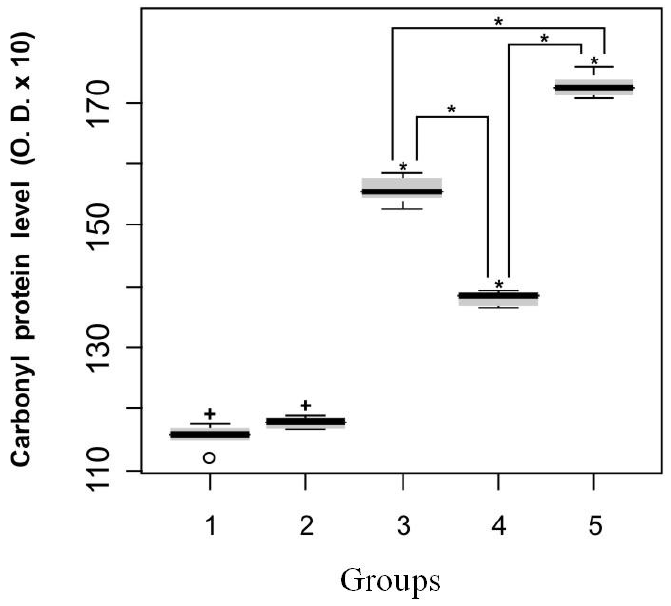
FIGURE 2 - Box plots of the protein carbonyl level (optical density (O.D.) x 10) determined in plasma samples from rats which underwent intestinal ischemia/reperfusion (I/R). Group 1- Control; Group 2 - Sham laparotomy with Propofol; Group 3 – I/R with Propofol; Group 4 - I/R with Propofol and N-Acetylcysteine (NAC); Group 5 - I/R with Ketamine and Xylazine solution, ( n = 8 in each group). The horizontal line in the box indicates the median. Data are presented as mean ± standard deviation. * P< 0.05 for I/R groups versus Control and Sham groups. + means P> 0.05 between Control and Sham